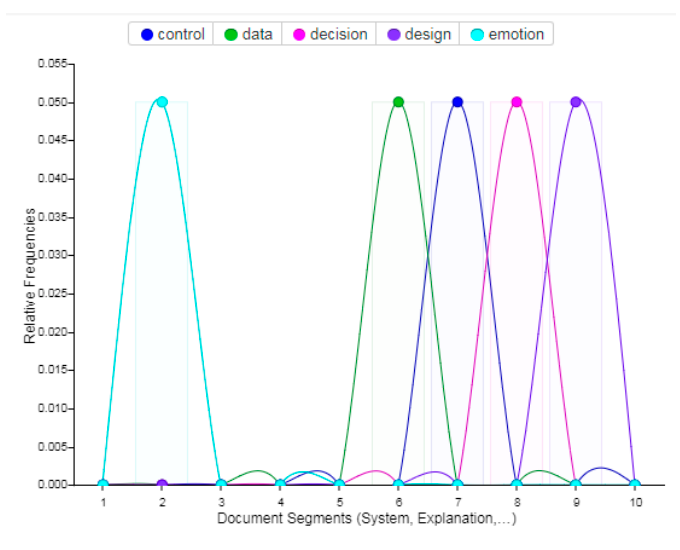
Figure 3. Word cloud 1 analysis.